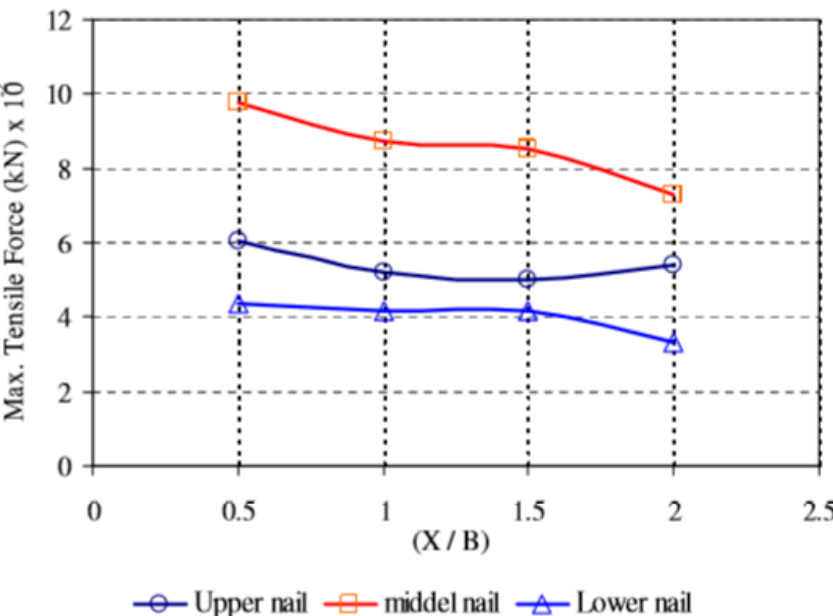
Figure 28. Influence of footing position on the maximum nail tensile force at levels.